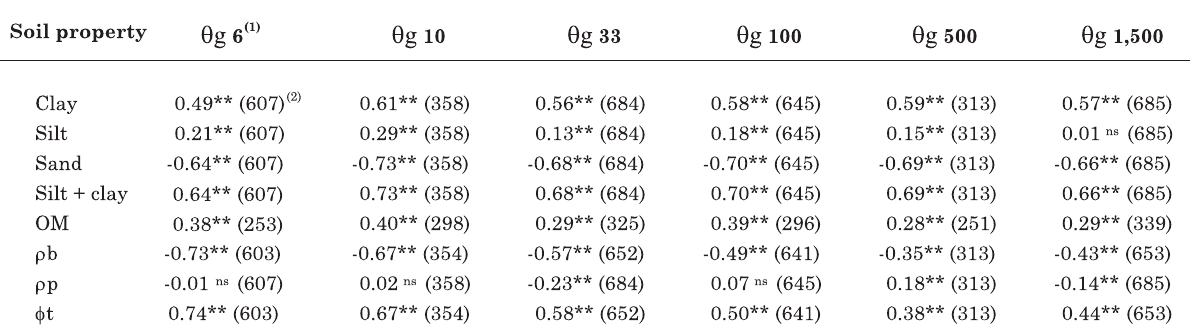
Table 3. Pearson correlation analysis between water retention at the tensions of 6, 10, 33, 100, 500 and 1,500 kPa with particle size distribution (clay, silt and sand), organic matter (OM), bulk density ( ρρρρρ b), particle density ( ρρρρρ p) and total porosity ( φφφφφ t)